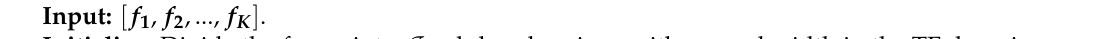
Algorithm 1 Sparse Component Separation